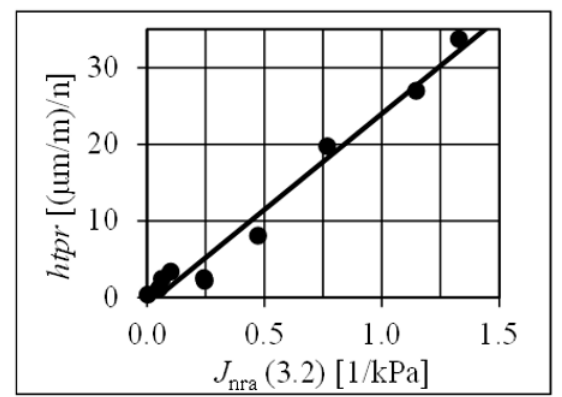
Figure 3. Correlation between high temperature performance ratio ofAC16asphaltmixesandaveragenon-recoverablecom- pliance of different binders